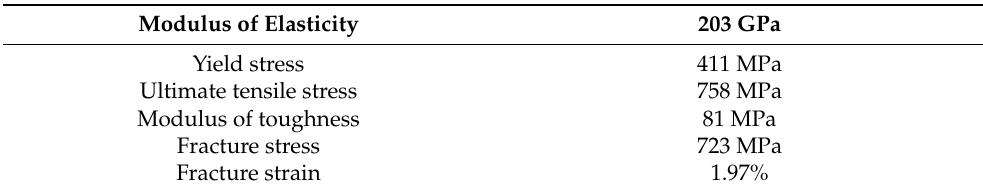
Table 2. Summary of the mechanical properties of D2 tool steel [39].